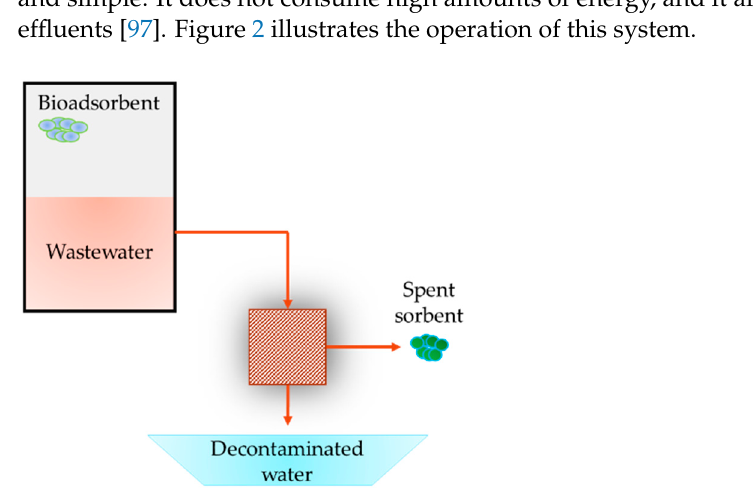
Figure 2. Functioning of the hormone abatement technique through organic adsorbents [96].